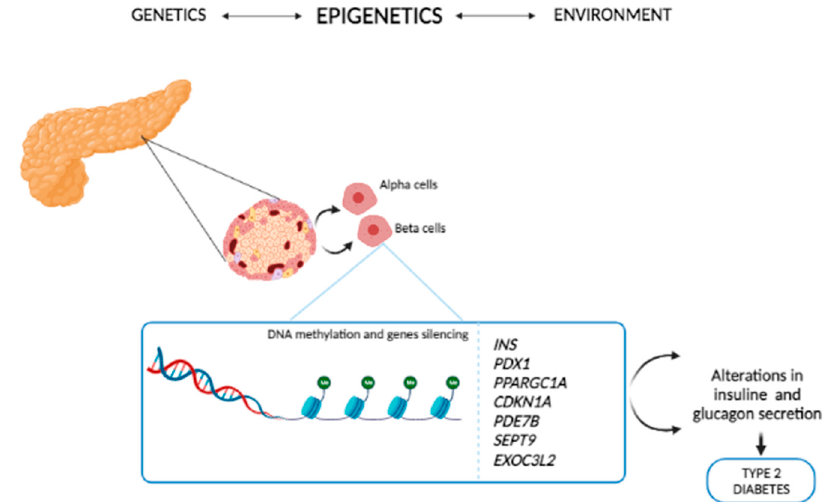
Figure 3. Effects of epigenetics in T2D gene regulation. The genes CDKN1A , PDE7B , SEPT9 , EXOC3L2 , INS , PDX1 and PPARGC1A regulate insulin, exocytosis in pancreatic β cells and glucagon secretion in α cells in T2D patients.